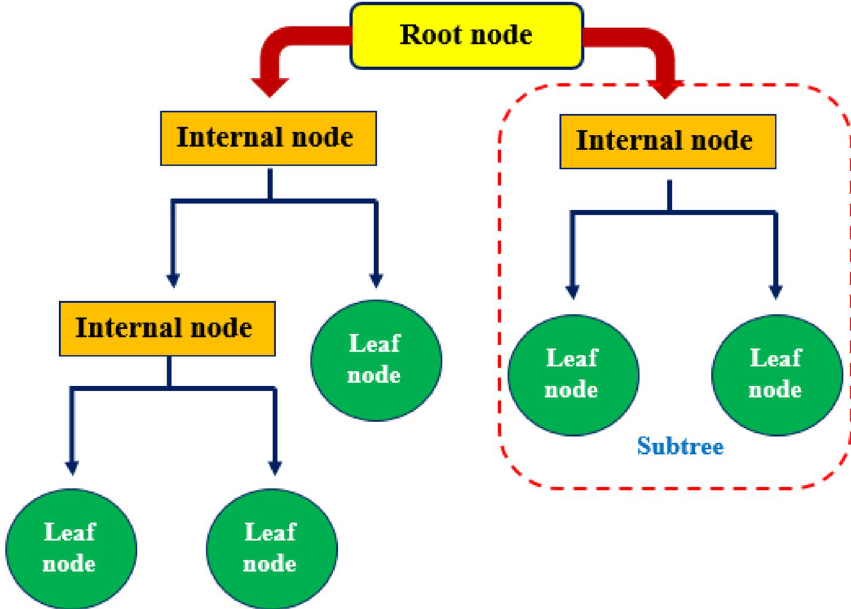
Figure 2. Schematic illustration of a typical decision